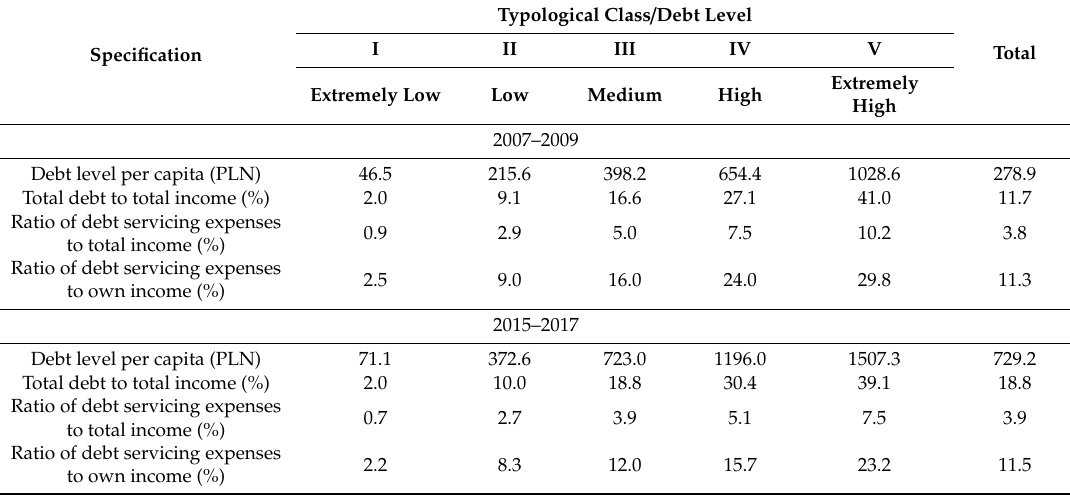
Table 5. Intra-class values of the simple characteristics of the debt levels in Polish rural municipalities (average values,